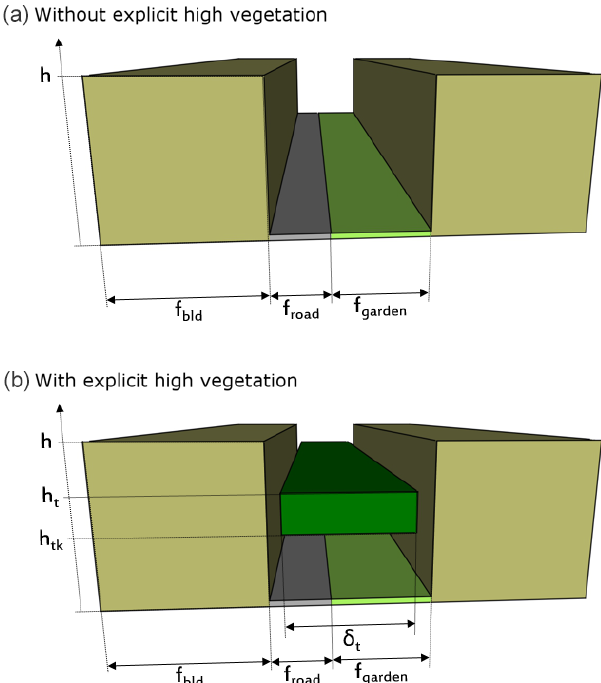
Figure 1. Comparison of the spatial arrangement of elements com- posing the urban canyon and of associated geometric parameters applied in the TEB model in the reference case (top) and in the case with explicit high vegetation